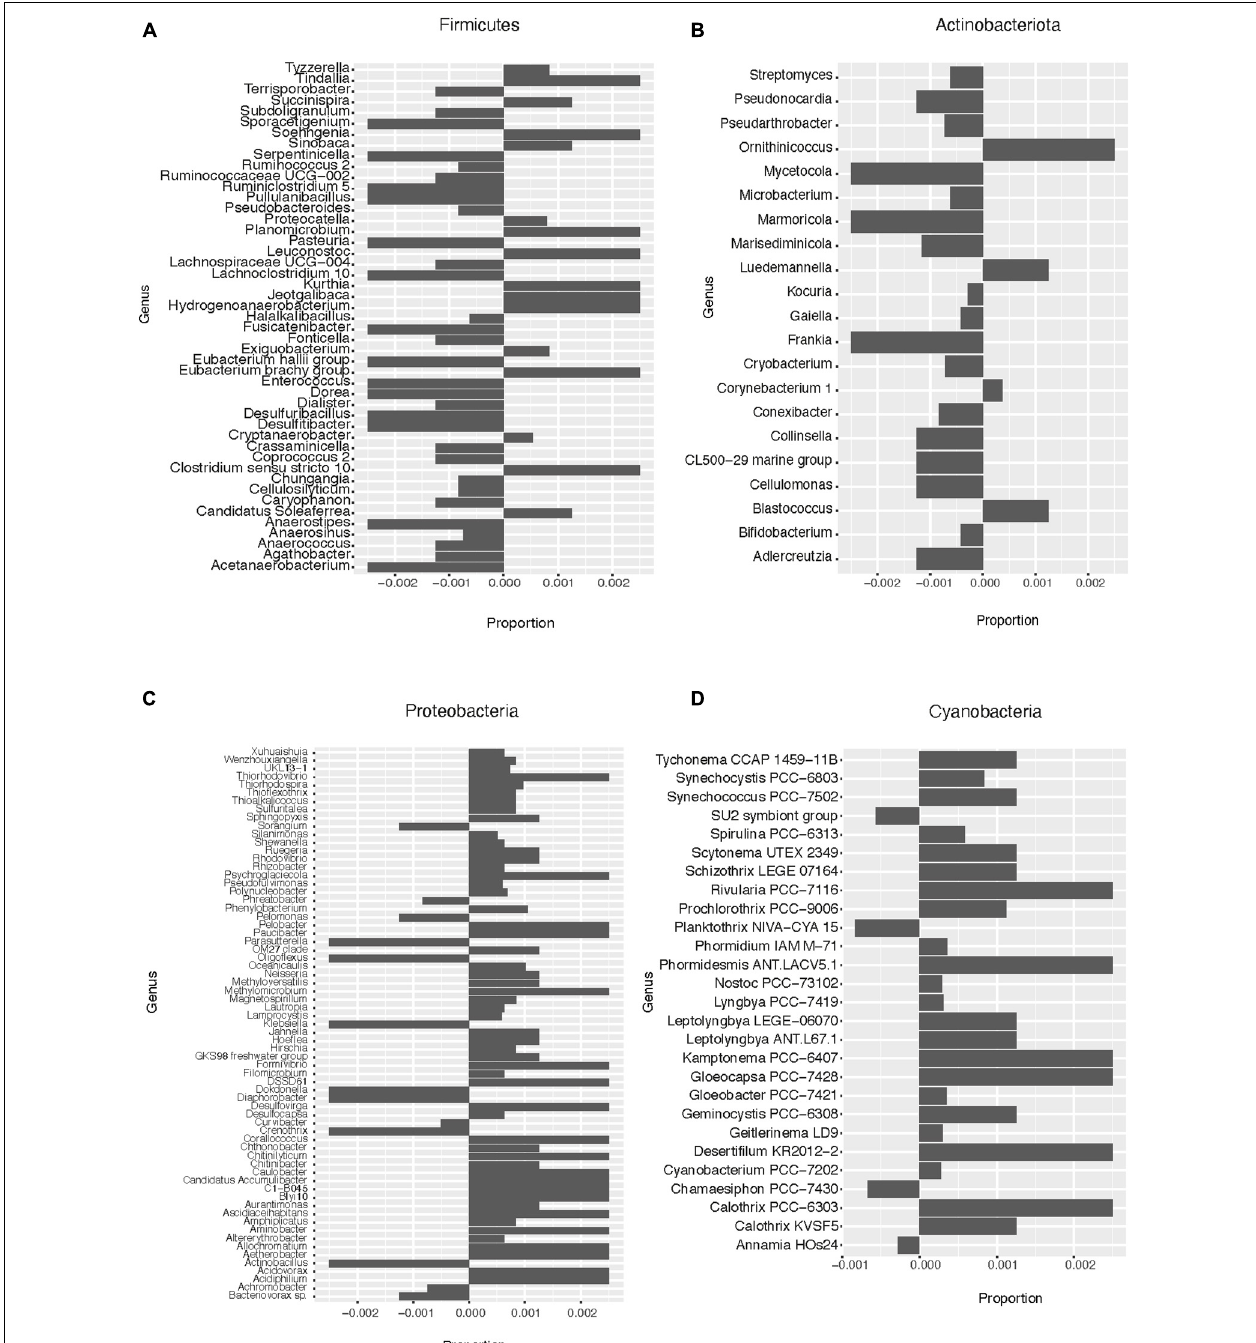
FIGURE 7 | Enrichment of different bacterial genera in the lysis-resistant or total fraction in the microbial mats. Negative values show enrichment in the lysis-resistant fraction, while positive values show enrichment in the total fraction for each genus. (A) Firmicutes genus. Proportion threshold at ≤ 0.0005 and > 0.0005. (B) Actinobacteria. Proportion threshold at ≤ 0.00025 and > 0.00025. (C) Proteobacteria. Proportion threshold at ≤ 0.0005 and > 0.0005. (D) Cyanobacteria. Proportion threshold at ≤ 0.00025 and > 0.00025.